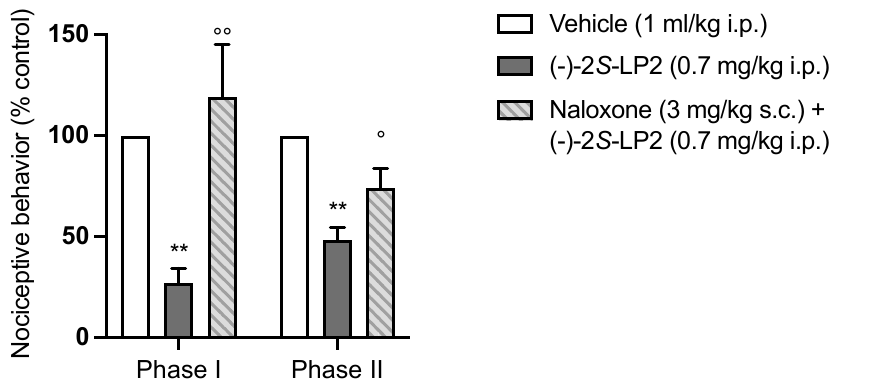
Figure 3. The antinociceptive effect of ( − )-2 S -LP2 was antagonized by naloxone pre-treatment. Subcutaneous administration of naloxone hydrochloride (3 mg/kg) 20 min before ( − )-2 S -LP2 reverted its effect in the formalin test. Results are expressed as mean ± SEM ( n = 6–8 mice per group) and are represented as the percentage of inhibition of pain responses of the respective vehicle group (100%). °° p < 0.01 vs. ( − )-2 S -LP2, ° p < 0.05 vs. ( − )-2SLP2, ** p < 0.01 vs. Vehicle, two-way ANOVA followed by Bonferroni post-hoc test.